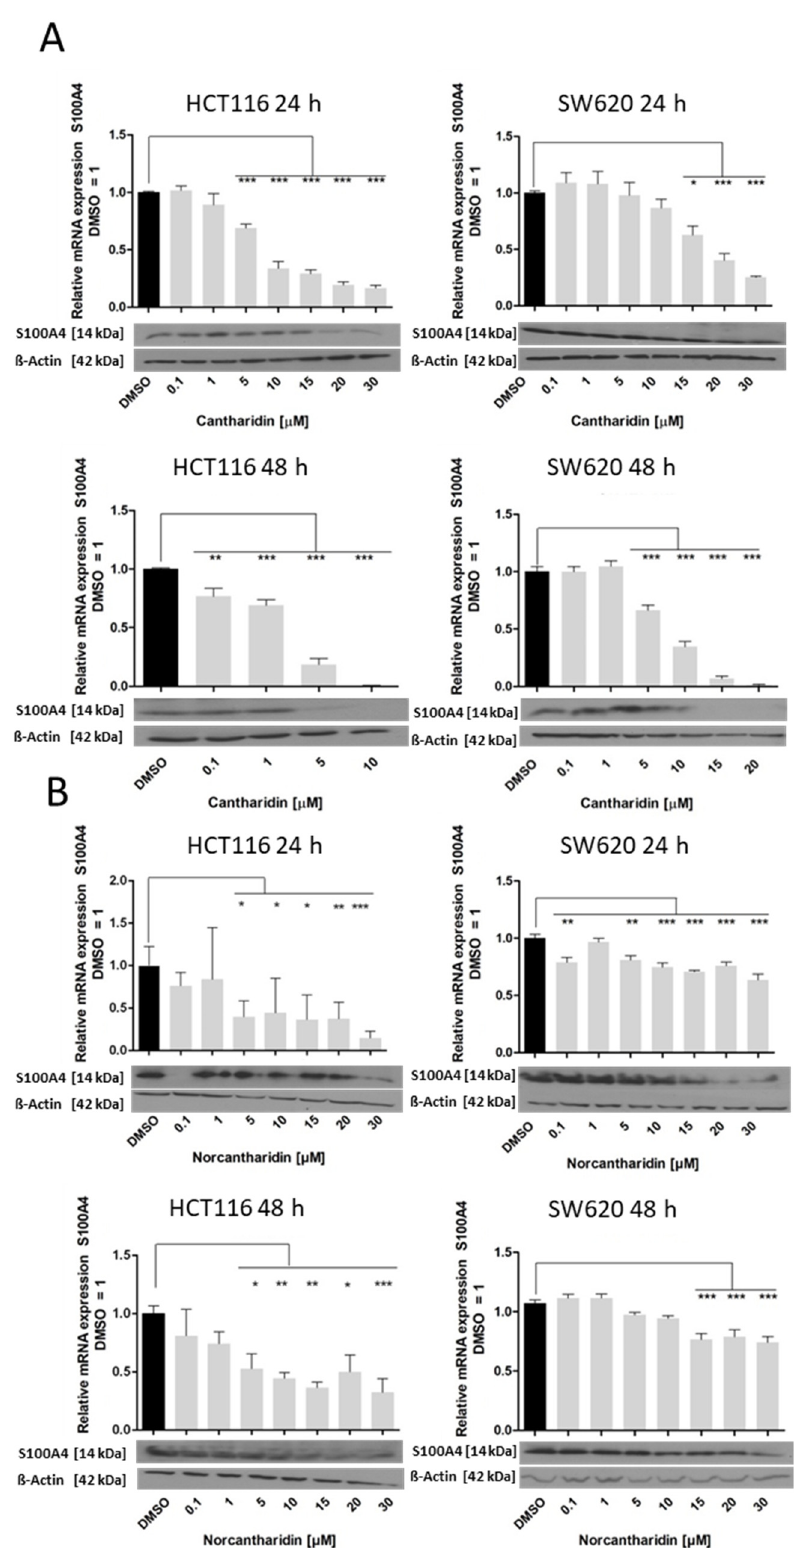
Figure 2. Effect of cantharidin and norcantharidin on S100A4 mRNA and protein expression after 24 h and 48 h. The HCT116 and SW620 cells were treated daily with increasing concentrations (0.1– 30 µM) vs. the DMSO control. RNA was extracted and RT-qPCR was conducted for the S100A4 mRNA represented as the percentage of the DMSO control of three independent experiments. The black bar indicates the DMSO control and the grey bars are the experimental samples which rep-